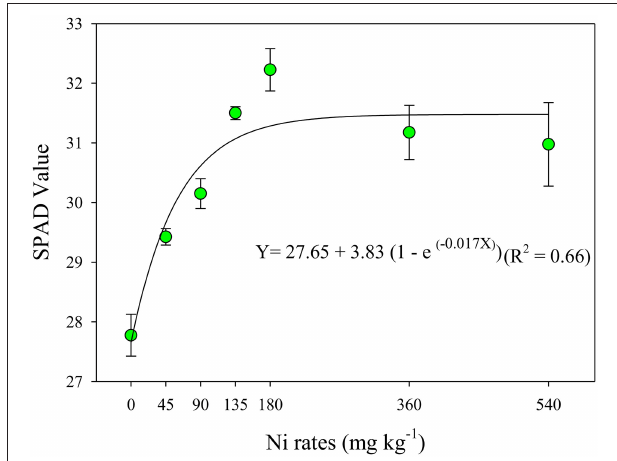
FIGURE 2 | SPAD value taken on the leaves of soybean cultivar BMX Potência RR , collected at R1 phenological stage ( Fehr et al., 1971), as related to Ni seed treatments (rates). Relative chlorophyll concentration in the leaf used for nutrient analysis assessed by SPAD measurements. The readings were taken using the middle third of the diagnostic leaf of plants in phenological stage R1, and the average was computed of 30 readings per plant of four replicates per treatment. Mean ± SD. (Fisher Test, p < 0.01 ).